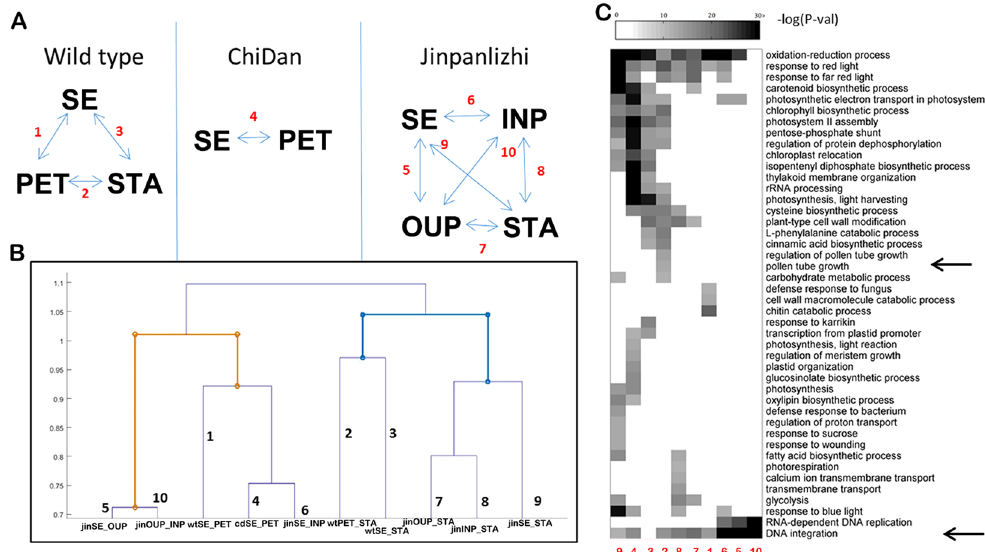
Figure 3. Functional characterizations of DEGs among homologous structural organs. ( A ) The overview of comparisons among organ types in wild and double flower cultivars. ( B ) The computed resemblances based on the presence and significance of all enriched GO terms. ( C ) the highly enriched ( KS < 0.00001) GO terms and their distributions among comparisons. Arrows indicate GO terms related to pollen tube growth and DNA integration respectively. The numbers indicate the pairs for comparison described in ( A ) SE, sepal; PET, petal; STA, stamen; OUP, outer petal; INP, inner